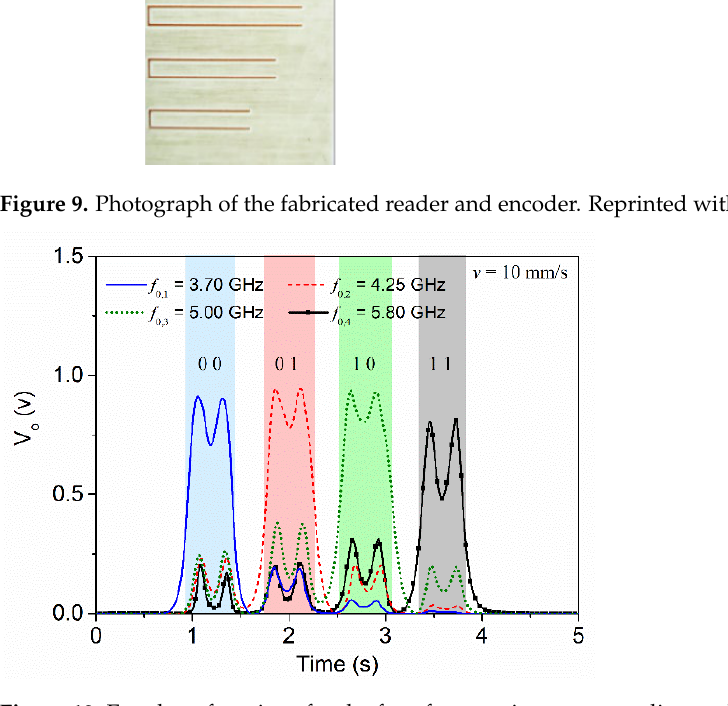
Figure 10. Envelope functions for the four frequencies corresponding to the (second) resonances of the four C-shaped resonators, for the tag depicted in Figure 9. Reprinted with permission from [65].